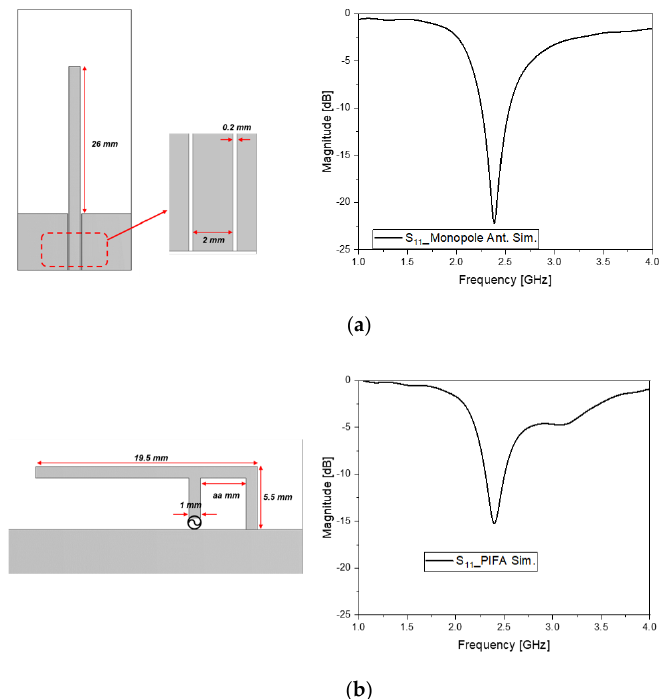
Figure 2. Checking the commonly used antennas. ( a ) Monopole antenna and its S 11 ; ( b ) PIFA antenna and its S 11 .